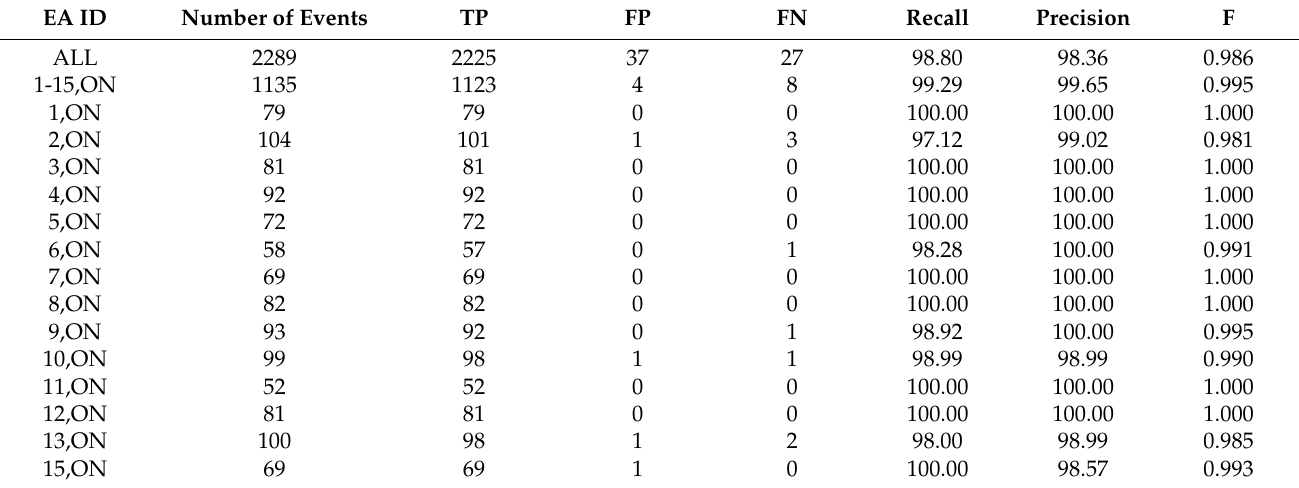
Table 7. Event detection results (switching on).